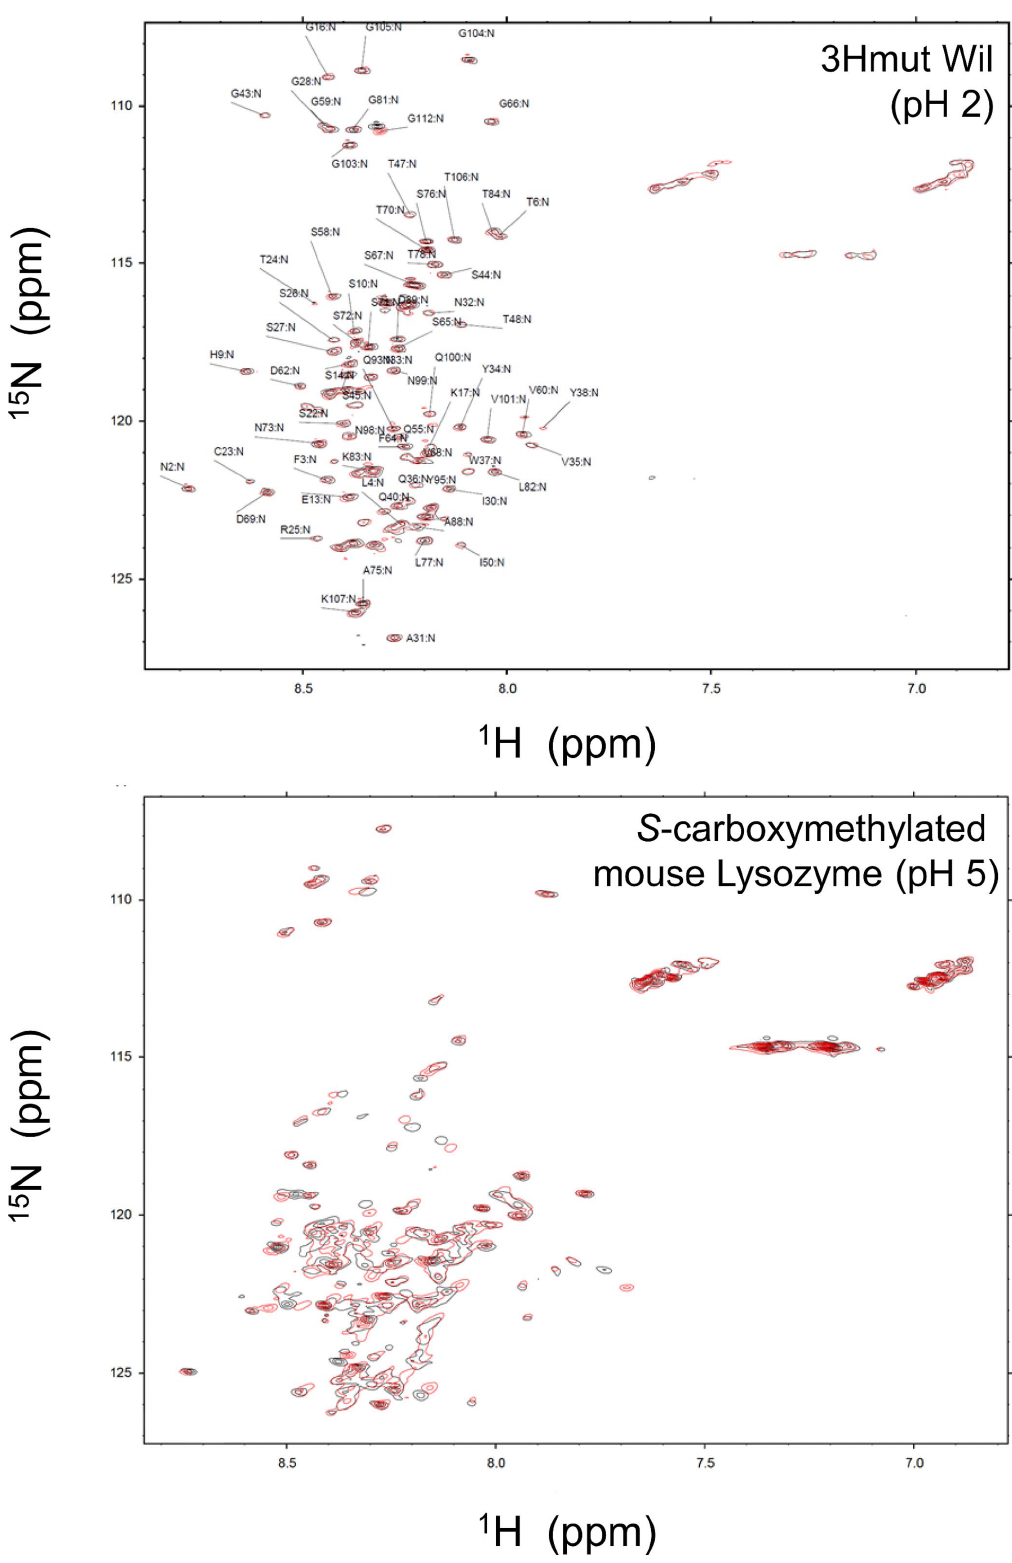
Figure 5. Effect of water soluble denatured protein mixtures on the solution structure of intrinsically disordered proteins. 1 H- 15 N HSQC spectra of the intrinsically disordered 3HmutWil and S -carboxymethylated mouse lysozyme in the absence (black) and presence (red) of HeLa cell TRIzol lysates. Assignments of 3HmutWil in the absence of lysate are indicated.